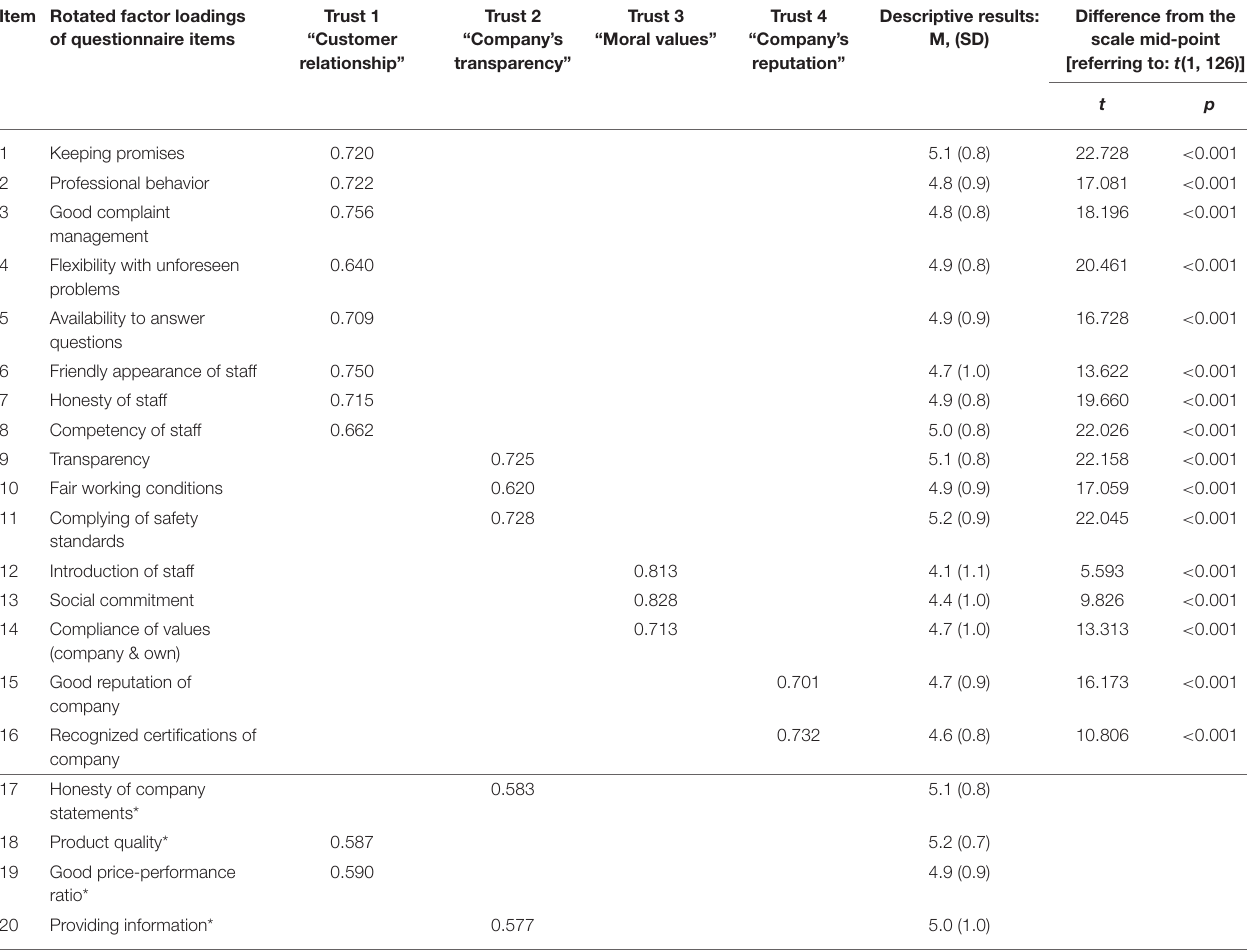
TABLE 3 | Results of trust items: PCA and descriptive statistical results (four items with factor loadings < 0.6 were excluded and are marked in the table with an asterisk). Item Rotated factor loadings of questionnaire